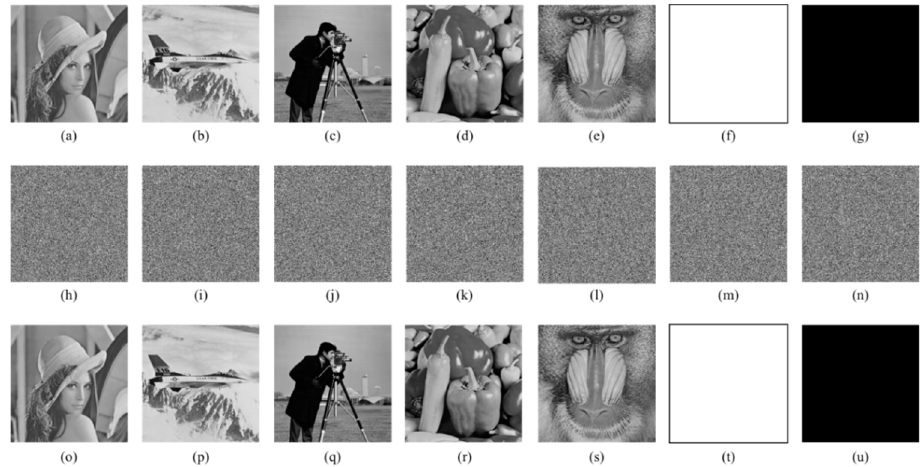
Figure 7. Encryption and decryption of grayscale images. ( a – g ) are all kinds of plaintext images, ( h – n ) are corresponding encrypted images, ( o – u ) are corresponding decrypted images.